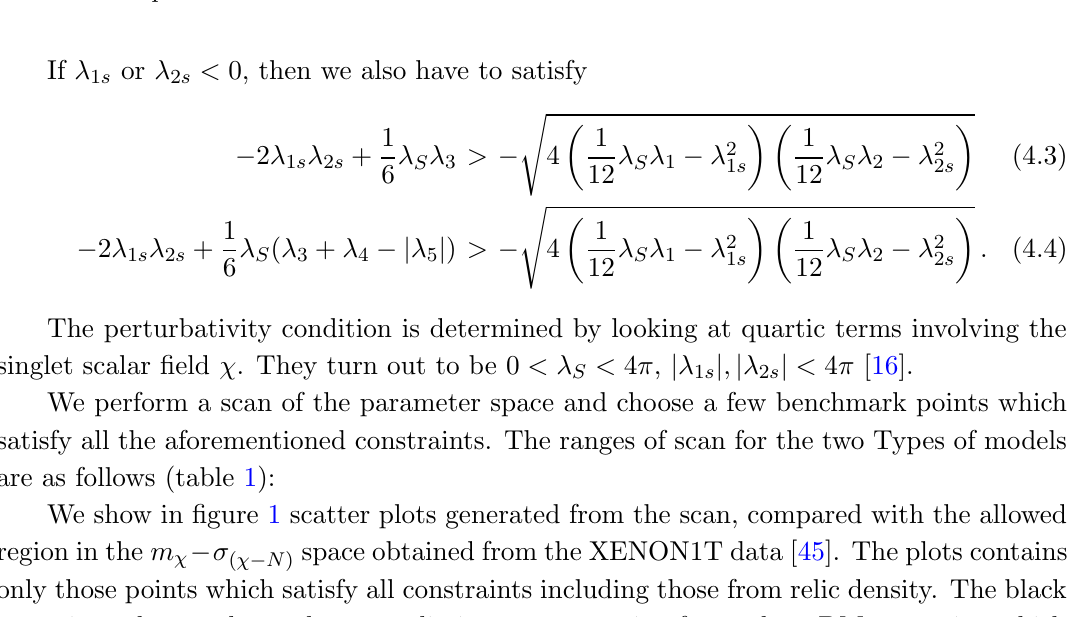
N scattering cross section from −